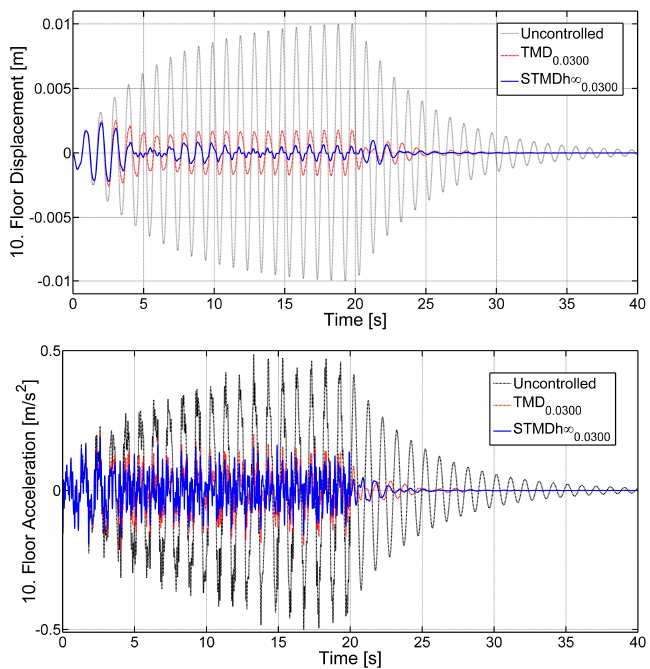
Figure 10. The TMD 0.0300 and the STMDh ∞ 0.0300 , the displacements (top) and accelerations (bottom) Figure 10. The TMD (cid:2868).(cid:2868)(cid:2871)(cid:2868)(cid:2868) and the STMDh∞ (cid:2868).(cid:2868)(cid:2871)(cid:2868)(cid:2868) , the displacements (top) and accelerations (bottom) under the Excitation-2 force. under the Excitation-2